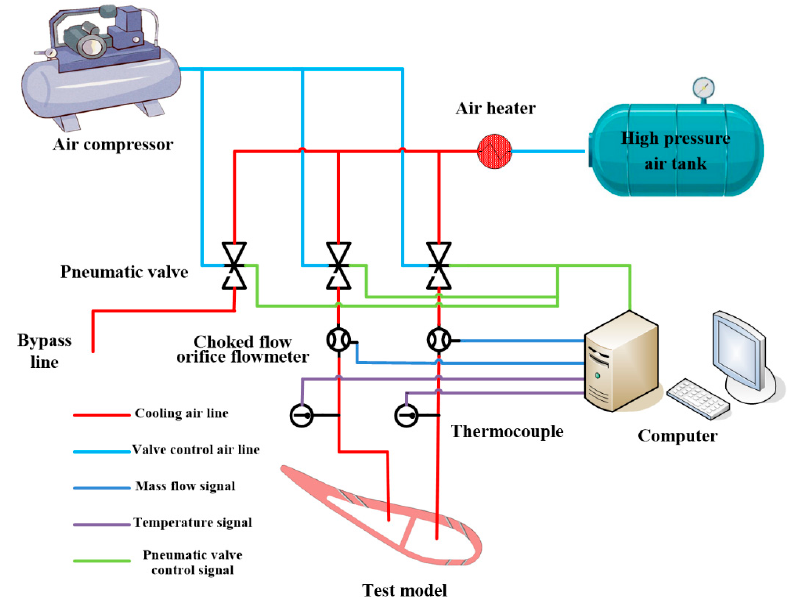
Figure 4. Schematics of the cooling air system.